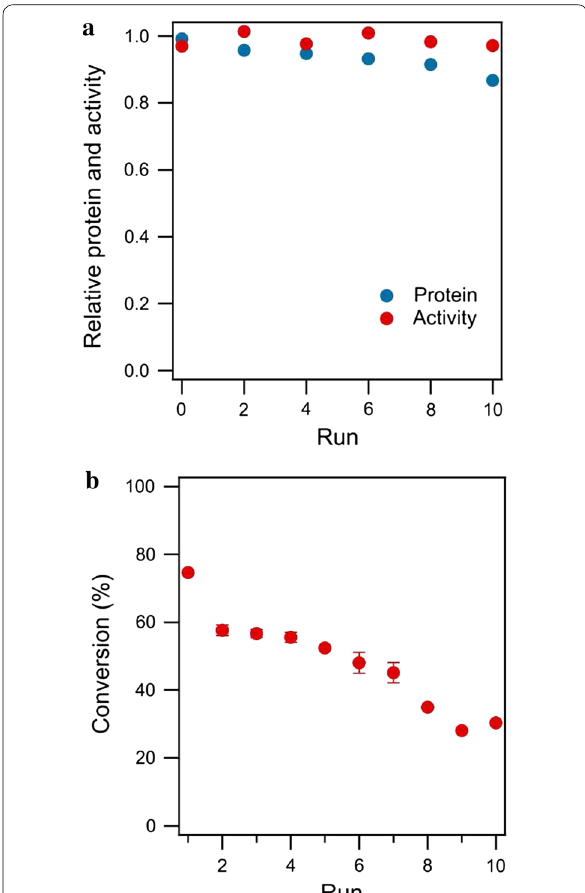
Fig. 7 a Effect of the repetitive dialysis on the protein concentration and activity of laccase. b Recyclability of DMELC for ABTS conversion (temperature, 30 °C, shaking speed, 180 rpm, ABTS concentration, 100 μM, pH, 4.5, 2.0 mg laccase, time of each DMELC, 180